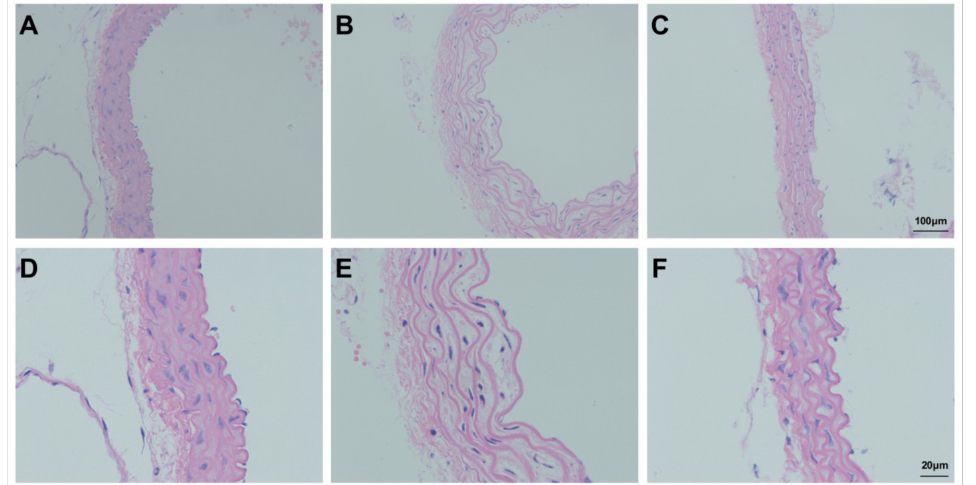
Figure 9. Morphological analysis of the aorta: ( A ) Con group; ( B ) Bl group; ( C ) Bl + MSC group; ( D ) Con group; ( E ) Bl group; ( F ) Bl + MSC group ( A – C , 100 × magnification; D – F , 400 × magnification).